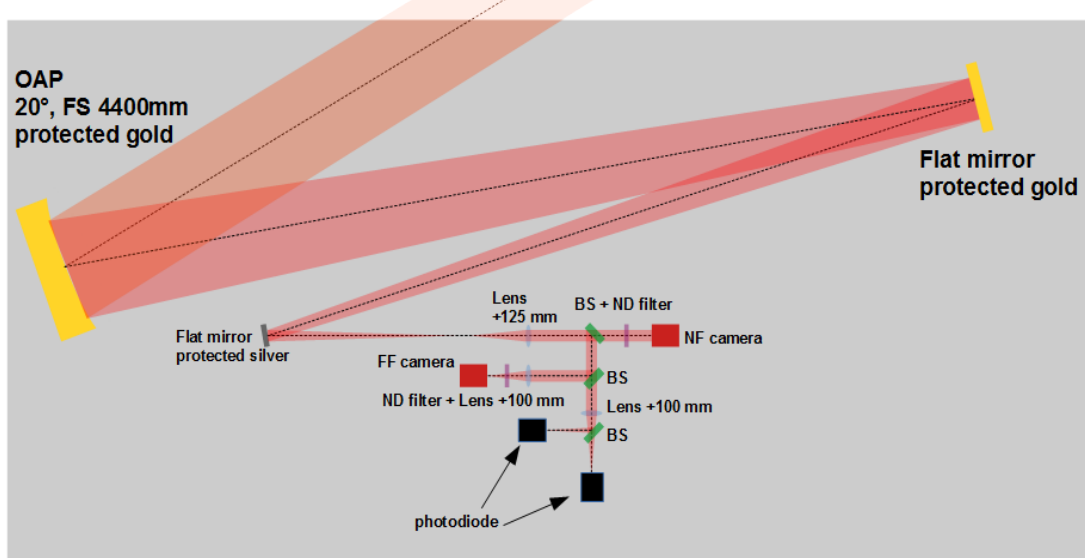
Figure 9. BDS optical setup. The laser beam is sent to the long focal-length OAP through a high-quality window available in the D2 vacuum chamber. After the focal point, the size of the beam is kept small, and it is split using a 2” beam splitter (BS) into four branches of the BDS: near field (NF), far field (FF) equipped with cameras and ND filters, and the two branches for the nanosecond-level intensity contrast of the beam, which is monitored using two fast